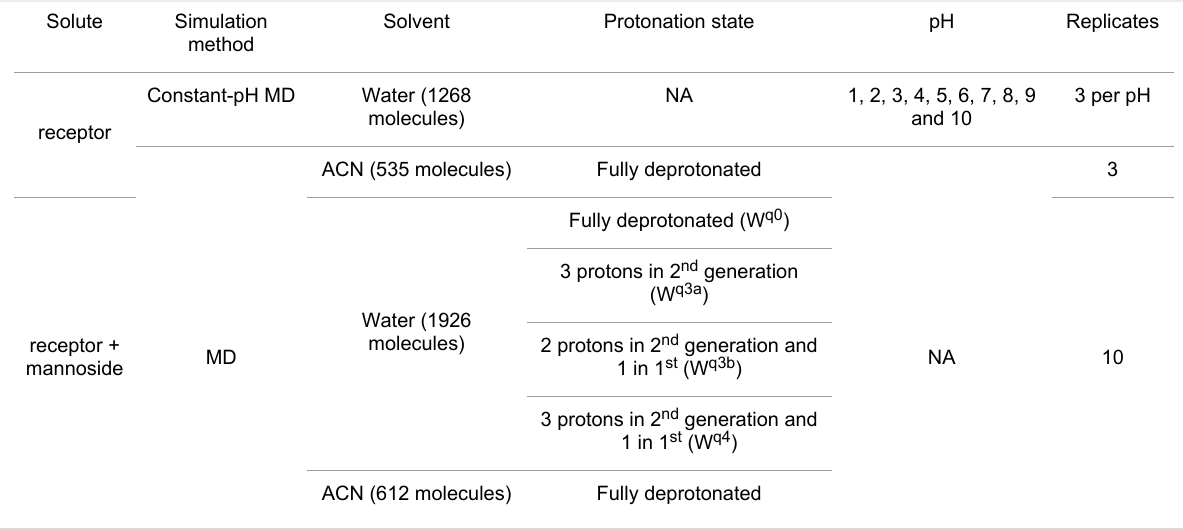
Table 1: Summary of the simulations used in this work. All replicates were run for 100 ns.